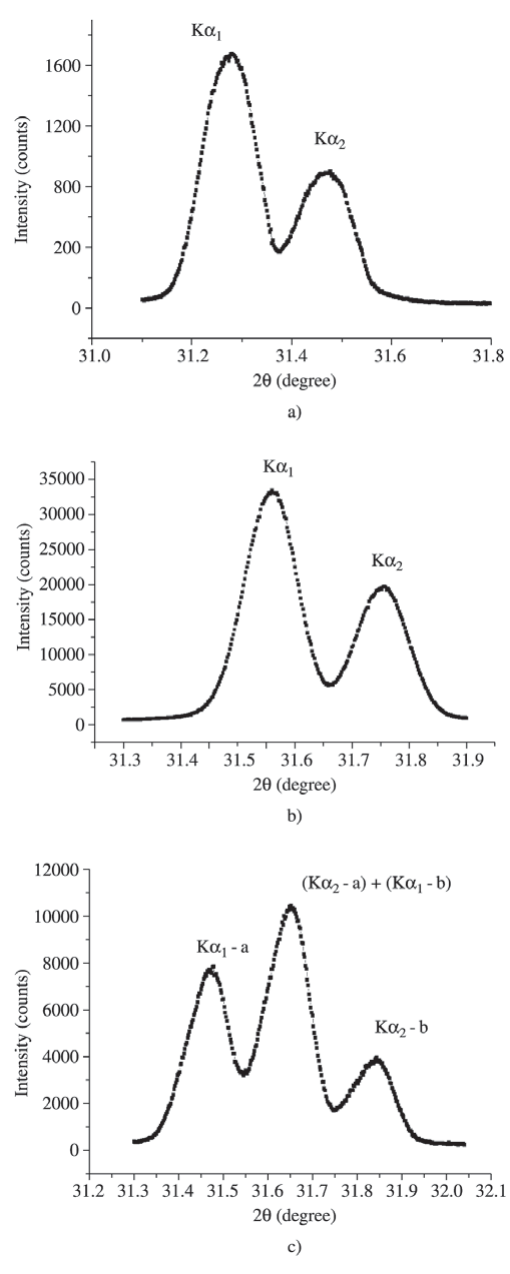
Figure 1. X-ray diffraction pattern for: a) (440) plane at room tem- perature; b) (440) plane near transition at 124 K; c) (800) plane for ferroelectric phase at 119